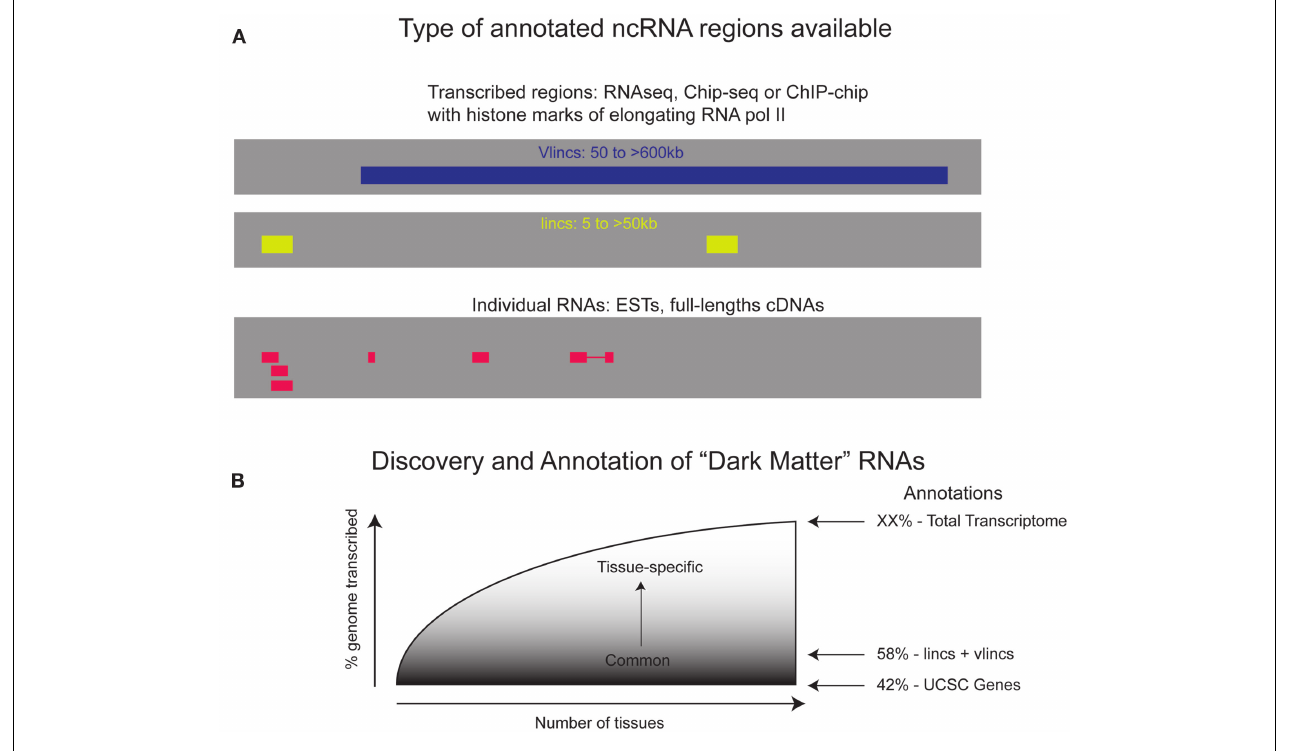
curve showing expected results of the fraction of the genome that is transcribed as a function of the number of biological sources whose RNA is profiled.The coverage of transcribed genome by protein coding genes including their introns is 42% and lincRNAs bring it up to 58%. However, the full extent of the transcribed genome is expected to be much greater than